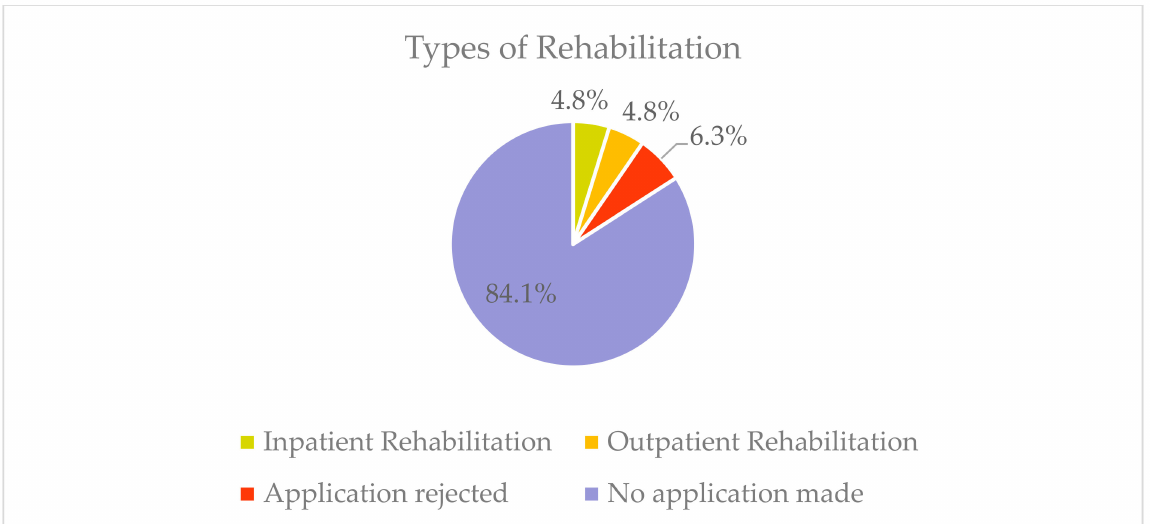
Figure 5. Relative frequencies of types of rehabilitation ( n =